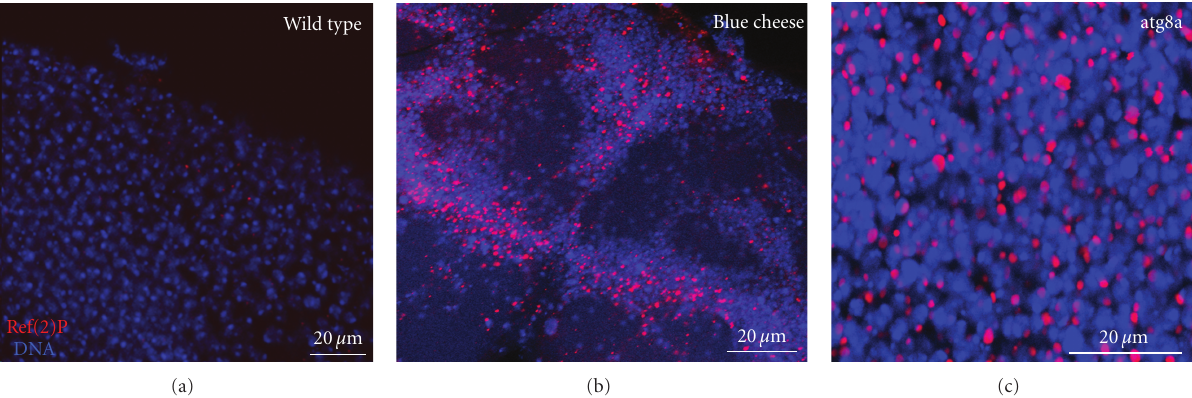
Figure 2: Ref(2)P accumulates in the adult brain of atg8a and blue cheese mutant flies. Confocal micrographs of superficial sections of the adult brain cortex of a wild-type fly (a), a blue cheese mutant fly (b), and an autophagy mutant fly (c). The tissues are stained for Ref(2)P (red) and DNA (blue). Ref(2)P accumulates ubiquitously into large sphere-shaped inclusion bodies/aggregates in blue cheese and autophagy mutants compared to wild